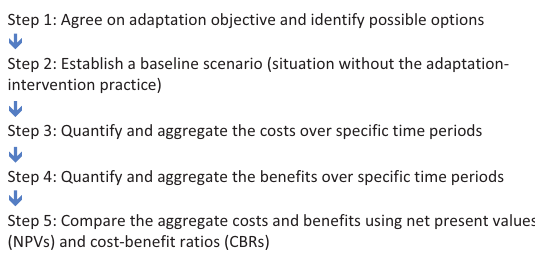
FIGURE 5: Steps in cost-benefit